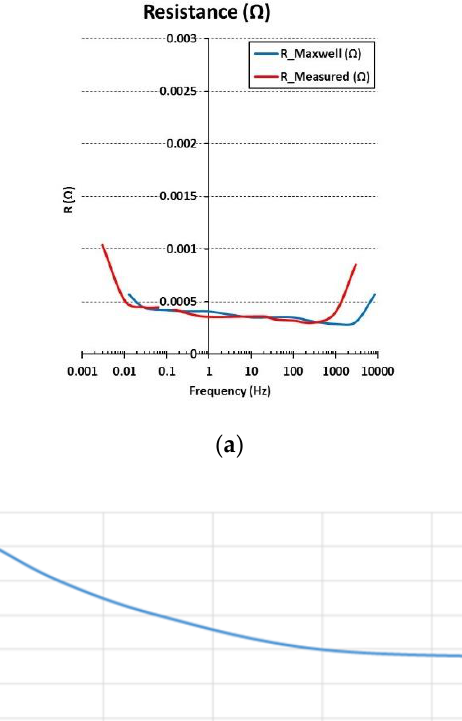
Table 4. Main parameters of SCs cell for different manufacturers.